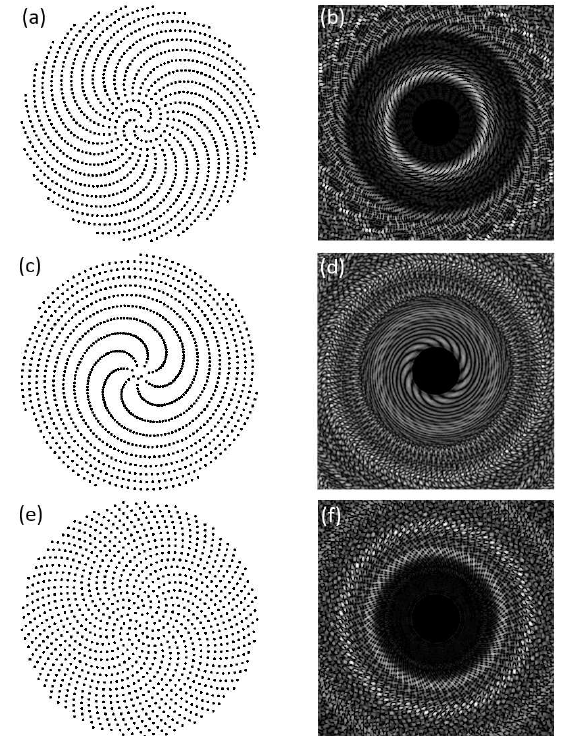
Figure 2. N = 1000 µ -spiral array ( a ), and its diffraction pattern ( b ); N = 1000 π -spiral array ( c ), and its diffraction pattern ( d ); N = 1000 τ -spiral array ( e ), and its diffraction pattern ( f ). The diffraction patterns are created with S λ 2 = 0.314, in an angular range of 80